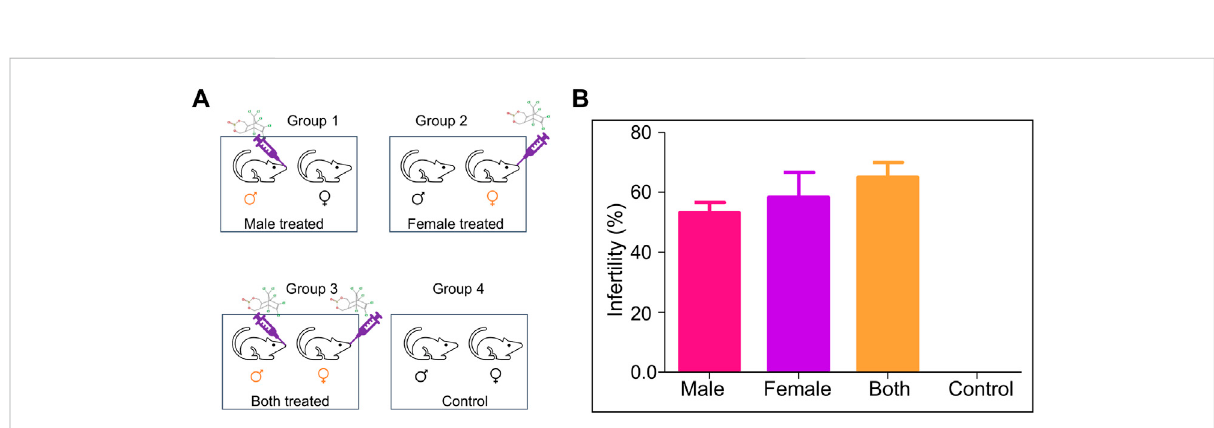
FIGURE 3 Evaluation of the effect of ES on fertility in mice. (A) Schematic is showing mating groups following exposure to endosulfan (5 mg/kg body weight); Group 1 (male treated), Group 2 (female treated), Group 3 (male and female treated), and Group 4 (untreated control). (B) Bar graphs show the difference in fertility levels when ES was given only to males ( n = 5), only to females ( n = 10), or to both males and females ( n = 15). Mating was in the ratio of 1:2 of male to female. Experiments were repeated 3 times. Error bars denote mean ±